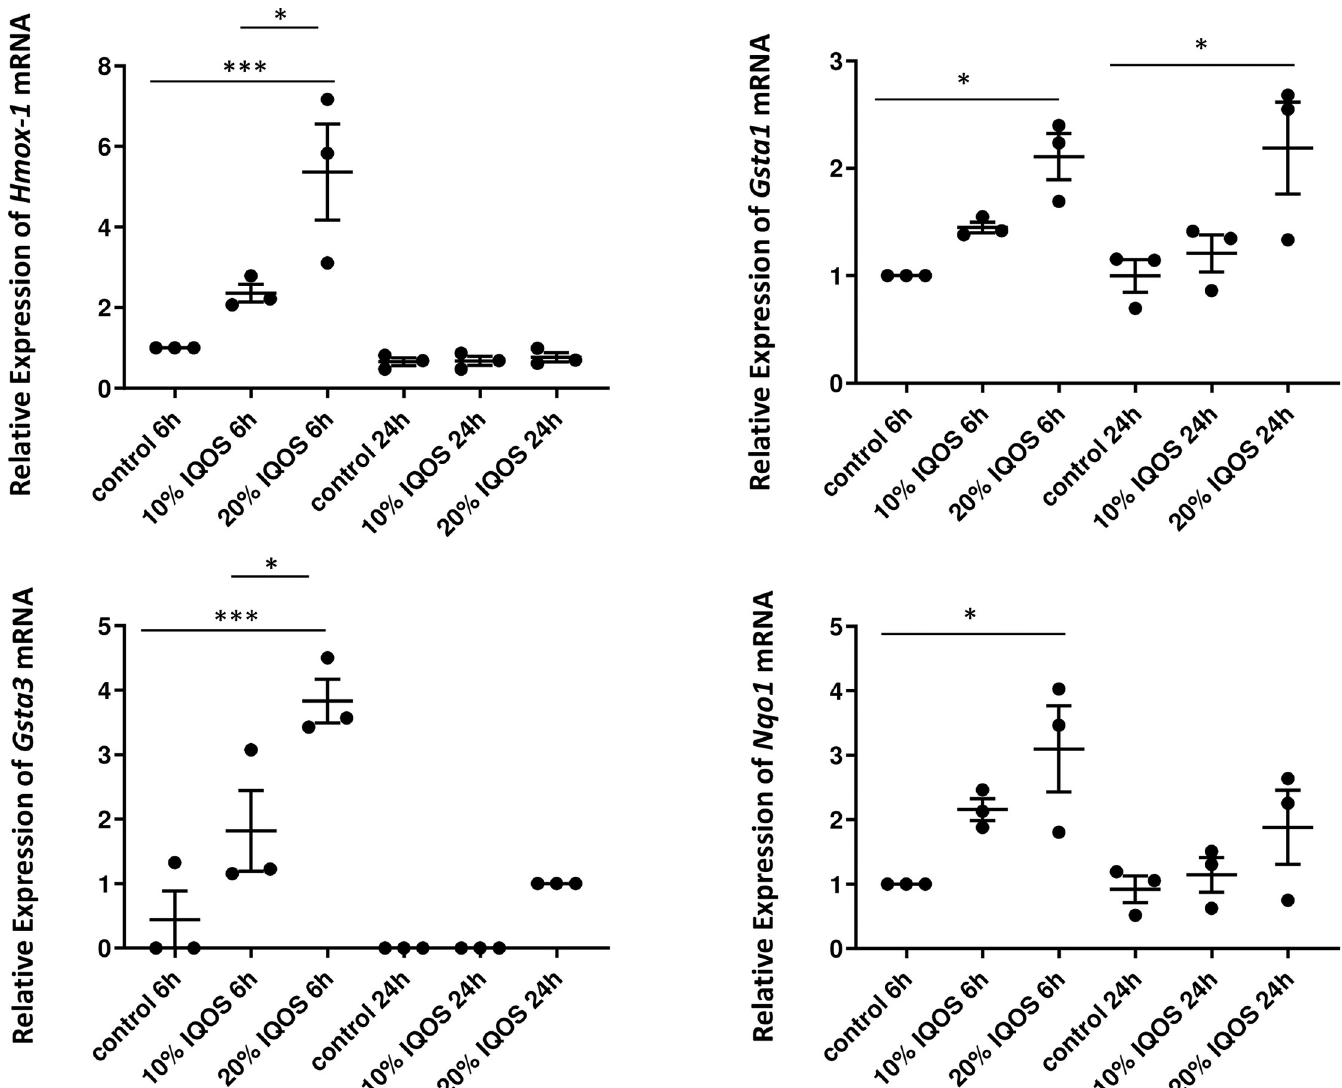
Fig 2. The expression levels of Hmox-1 , Gsta1 , Gsta3 and Nqo1 mRNA in rat ATI-like cells are upregulated at 6 h after stimulation with 10% and/or 20% IQOS CSE. Only Gsta1 mRNA expression is upregulated at 24 h after stimulation with 20% IQOS CSE. Data represent results from three independent experiments. Each experiment was done in duplicate or triplicate wells. � : p < 0.05, ��� : p < 0.001.